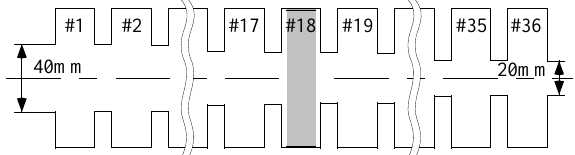
FIG. 12. 36-cell test structure with damper in cell